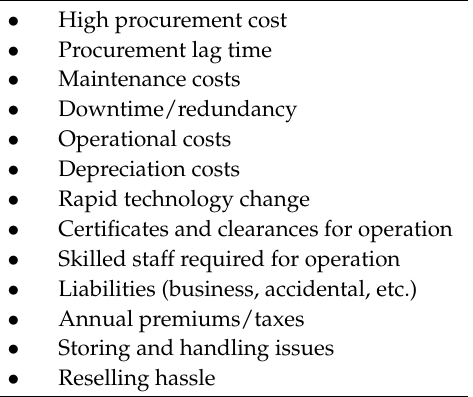
Table 1. List of common barriers among different products and